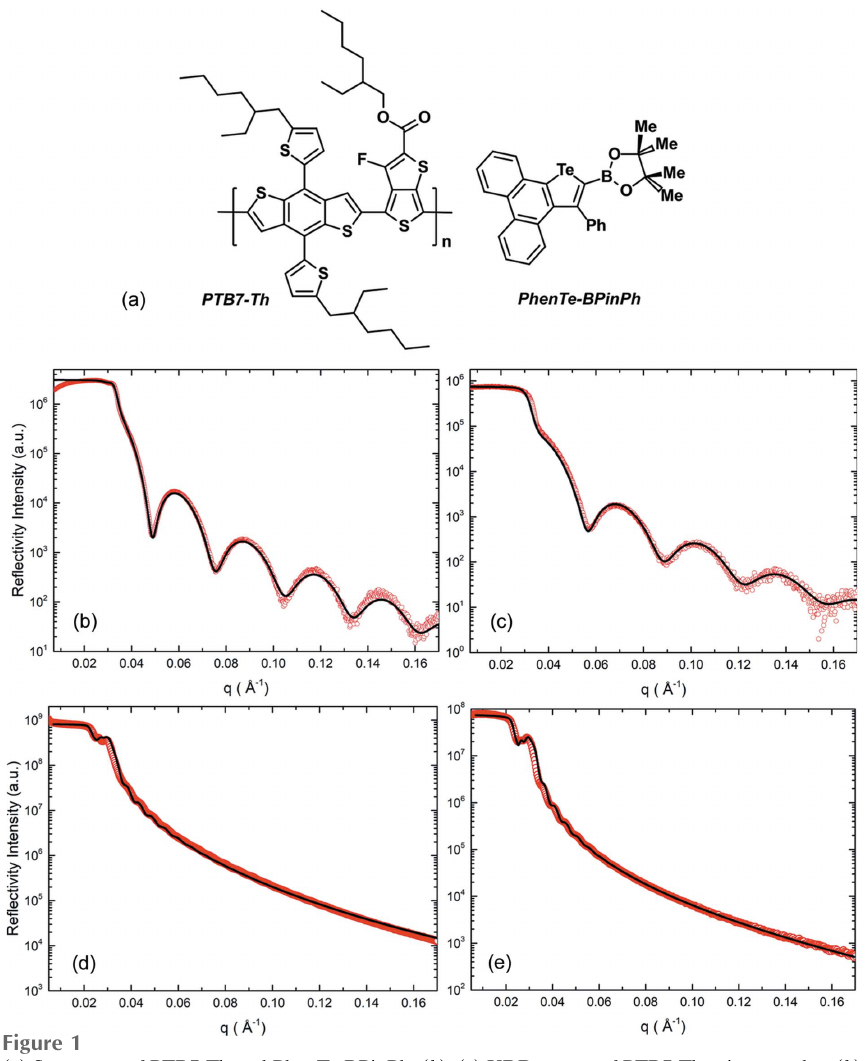
Figure 1 ( a ) Structures of PTB7-Th and PhenTe-BPinPh. ( b )–( e ) XRR curves of PTB7-Th spin-coated at ( b ) 1000 rpm on glass and ( c ) 1500 rpm on silicon with fit (solid line), and of PhenTe-BPinPh spin-coated at 1000 rpm on silicon ( d ) with subsequent SVA and ( e ) without